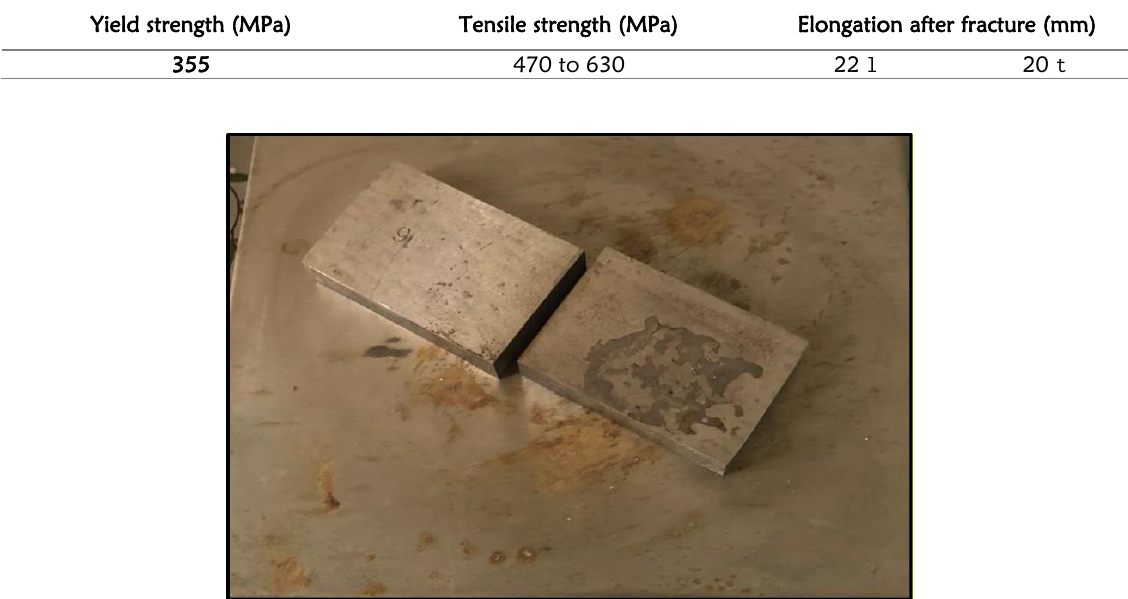
Table 2: mechanical properties of carbon steel (measured).